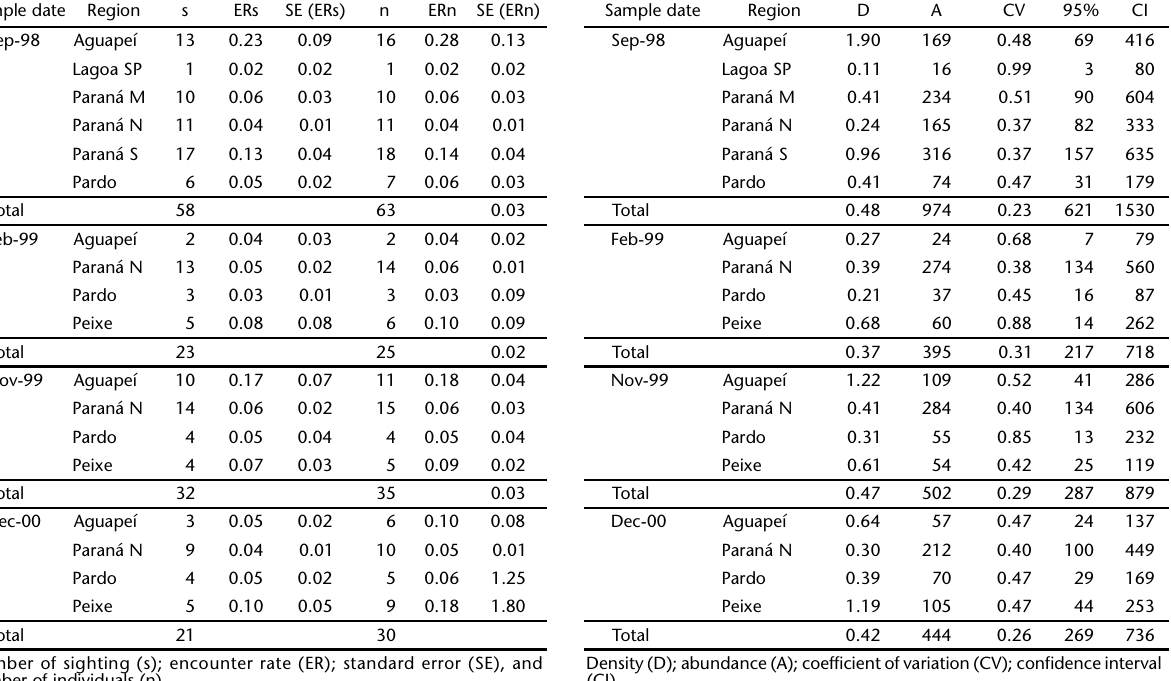
Table III. Parameters estimated based on the surveys of marsh deer along the Paraná Basin in different years.